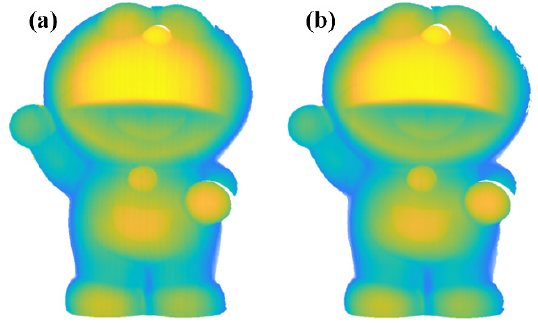
Figure 9. Three-dimensional reconstruction of the sculpture of Doraemon. ( a ) The proposed method. ( b ) Method in Ref. [32].